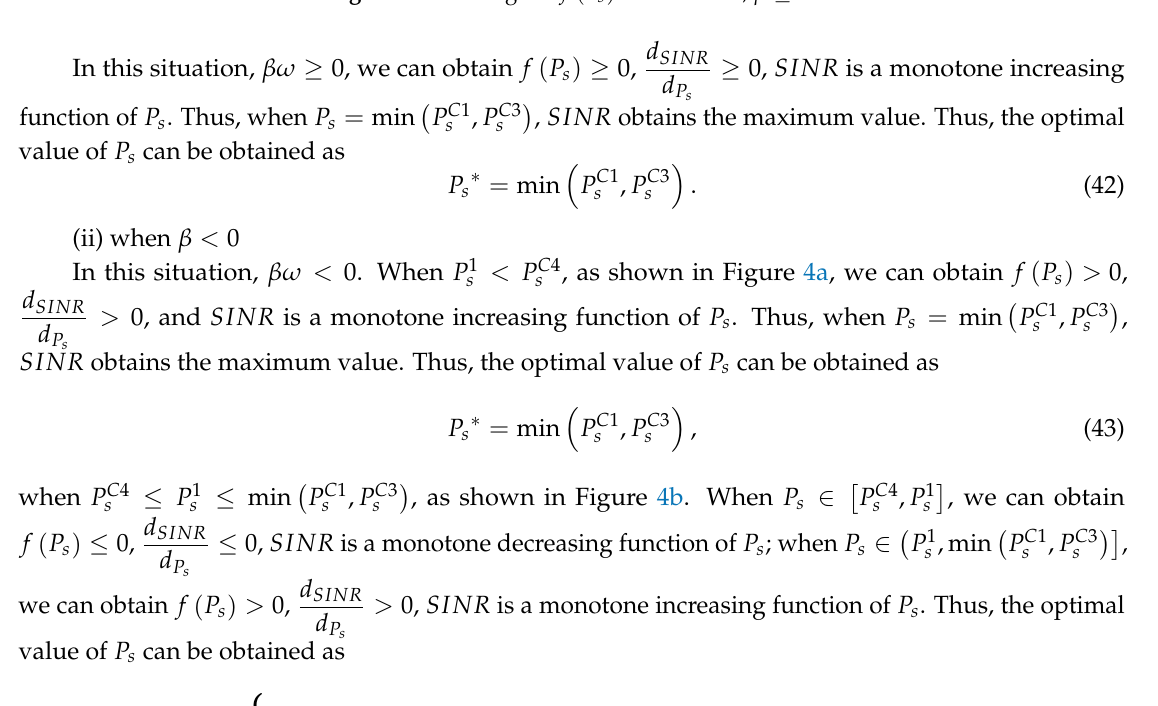
Figure 3. The image of f ( P s ) when ω > 0, β ≥